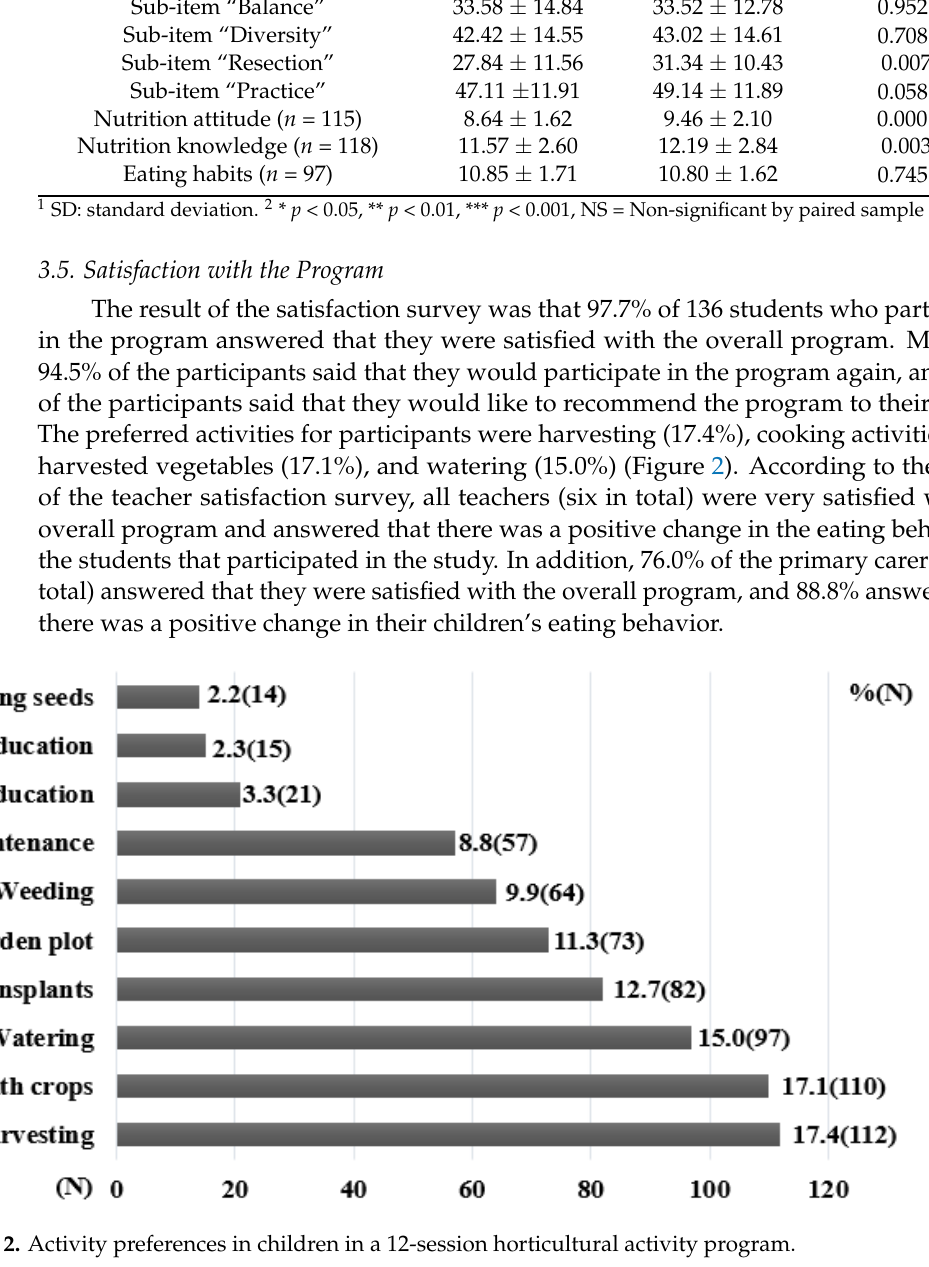
Figure 2. Activity preferences in children in a 12-session horticultural activity